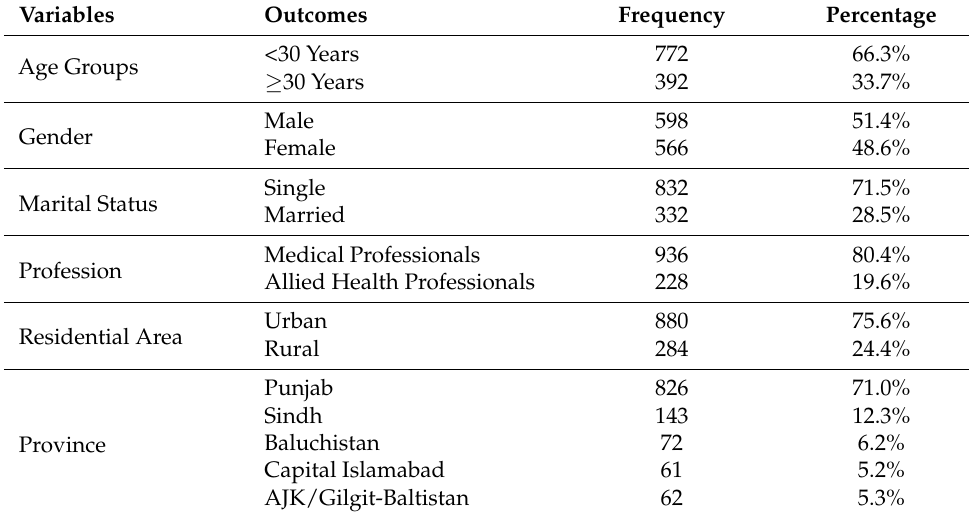
Table 1. Demographic details of the respondents (N =